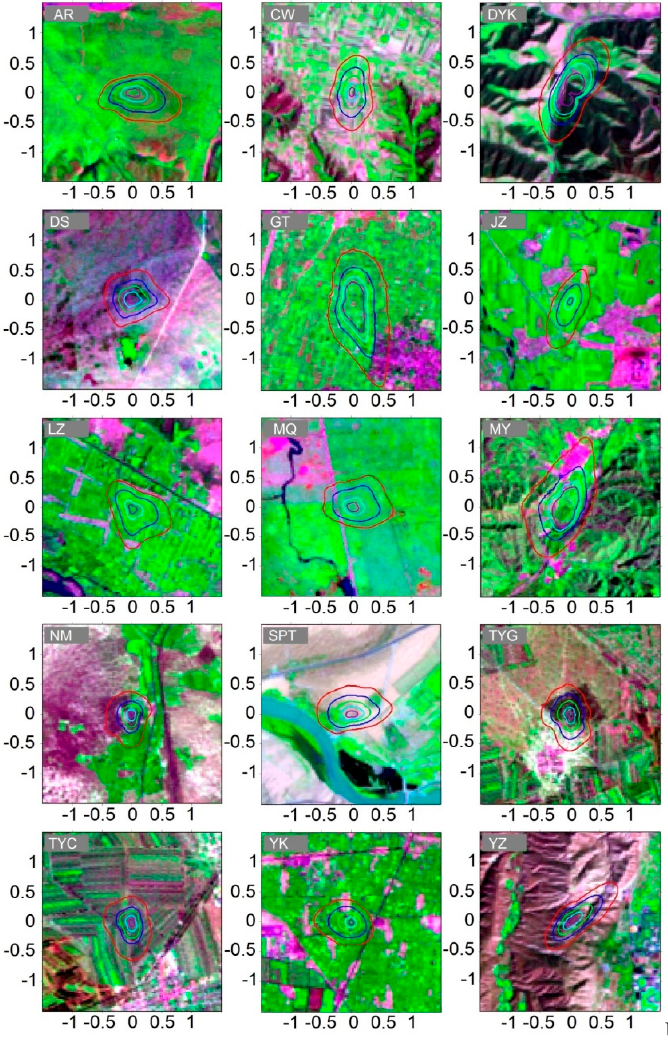
Figure 2. Color composite images (bands 7, 4 and 2) of Landsat at a 30 m resolution for each area (3 km × 3 km) centered at individual flux sites and the contours of cumulative annual footprint climatology of the observation period. The keys of the contour line for percentage of total footprint are: purple, 60%; cyan, 80%; green, 90%; blue, 95%; and red, 99%.